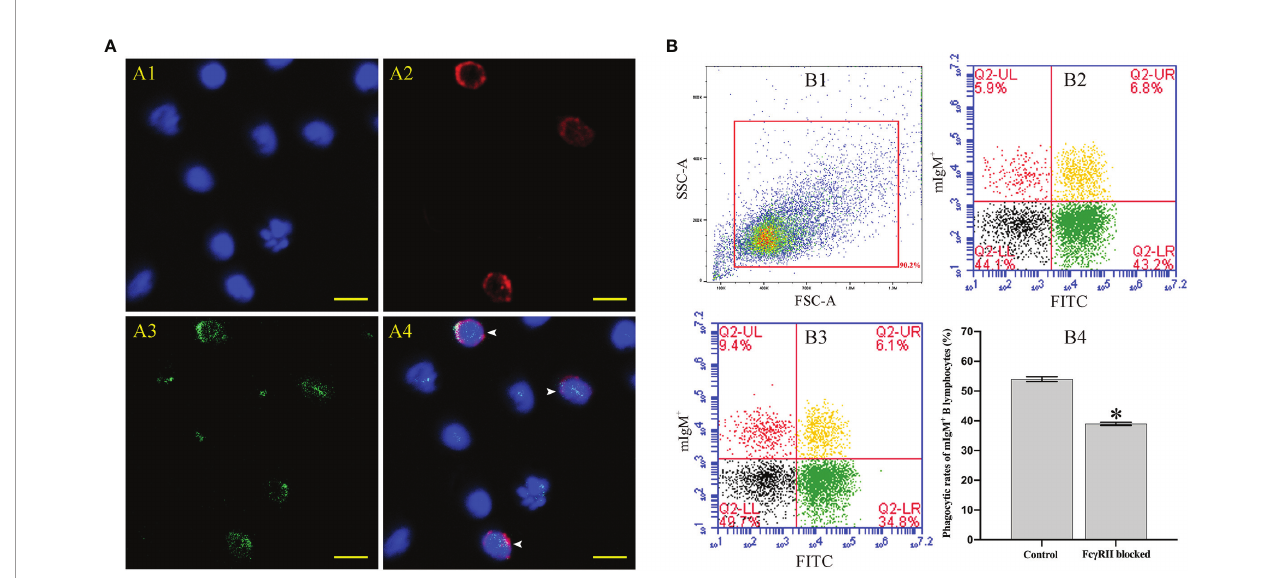
FIGURE 8 | The distribution characteristics of Fc g RII and its effect on mIgM + B lymphocytes ADCP. (A) IFA analysis of distribution characteristics of Fc g RII in PBLs. A1: DAPI staining of cell nuclei. A2: Immuno fl uorescence-stained leukocytes with anti-IgM mAb and Alexa Fluor ® 649 goat anti-mouse IgG. A3: Immuno fl uorescence-stained leukocytes with rabbit anti-rFc g RII antibodies and Alexa Fluor ® 488 goat anti-rabbit IgG. A4: Merge images of each fl uorescent channel and arrows indicate the Fc g RII + / mIgM + B lymphocytes (Bar = 10 m m). (B) Flow cytometry analysis of phagocytosis rates of Fc g RII-blocked mIgM + B lymphocytes after incubation with antiserum-opsonized E. tarda . B1: FSC/SSC plots of PBLs. B2: Co-incubation with Fc g RII-blocked PBLs and antiserum-opsonized E. tarda . B3: Co-incubation with PBLs and antiserum- opsonized E. tarda . B4: Phagocytosis rates of mIgM + B lymphocytes summarized from the fl uorescence scatter plots. Error bars indicate the standard deviation of the three biological replicates. The asterisks on the bars represent the statistical difference of the phagocytosis rates compared to the control group ( p <